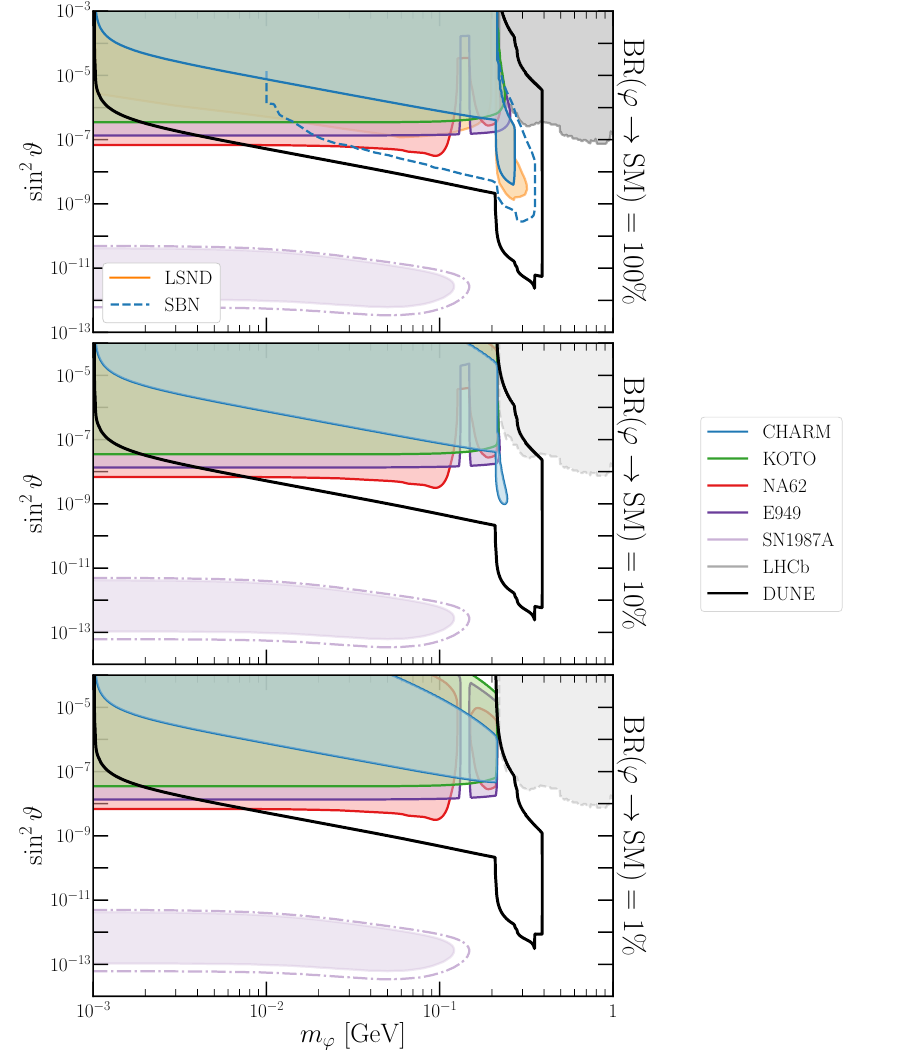
Figure 5 . Limits on the scalar mass m ϕ and the mixing parameter sin 2 ϑ . For each panel, we make a different assumption about the BR of ϕ into SM particles. The left panel assumes 100%, the center 10%, and the right 1%. We include constraints from CHARM (blue) [53, 100], KOTO (green) [101], NA62 (red) [56], E949 (purple) [55], LHCb (gray) [102, 103], projections from DUNE (black) in all panels, as well as constraints from LSND (orange) [98] and SBN projections from SBND and ICARUS (dashed blue) [71] in the left panel. The supernova constraints assuming the luminosities of 3 × 10 53 erg/sec and 5 × 10 53 erg/sec are shown respectively by the dot-dashed purple contours and purple shaded regions [104,